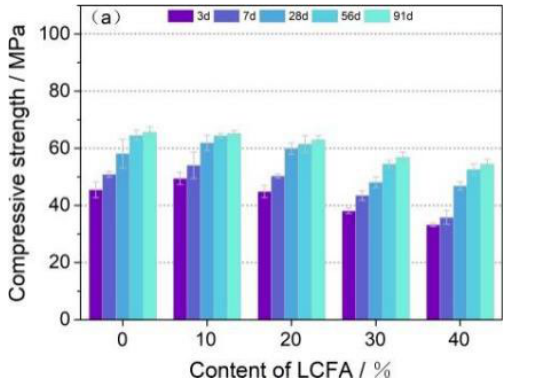
Figure 8. Compressive strength of OPC-FA samples. ( a ) Dry. ( b ) Water . 3.3.2. Compressive Strength Figure 9 shows the influence of curing conditions and content on the compressive strength of OPC-LCFA-FA (20% LCFA + FA) samples. In general, the compressive strength of samples decreased first and then increased with the increase of LCFA content. Figure 9a,b show the effects of dry and water curing on the compressive strength of OPC- LCFA-FA samples, respectively. Further, water curing promotes the strength develop- ment of OPC-LCFA-FA samples. As can be seen from Figure 9, after 91 days of water